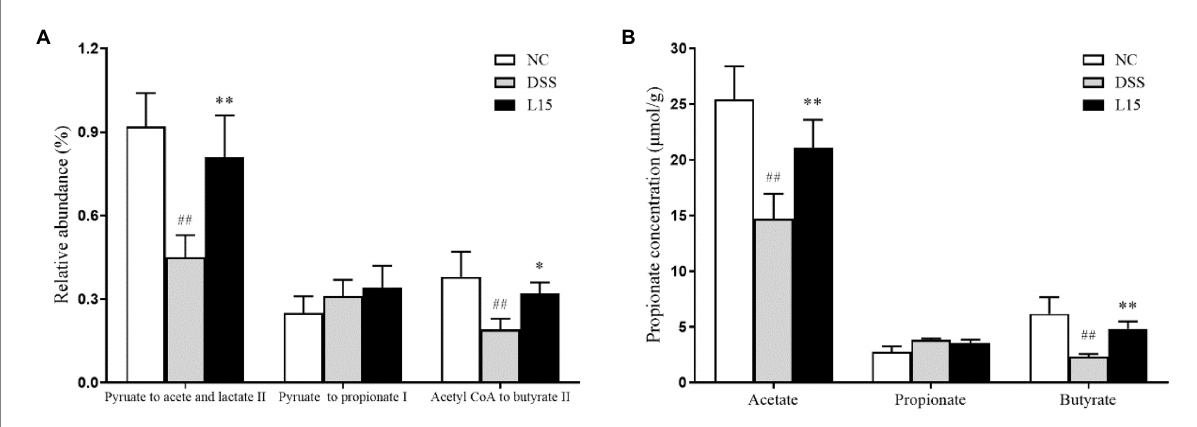
FIGURE 8 The relative abundance of pathways related to SCFAs production in the cecal contents was predicted using the PICRUSt (A) , and GC determined SCFAs production in the cecal contents (B) . NC, normal control group; DSS, dextran sulfate sodium-induced colitis group; L15, Supplement L.